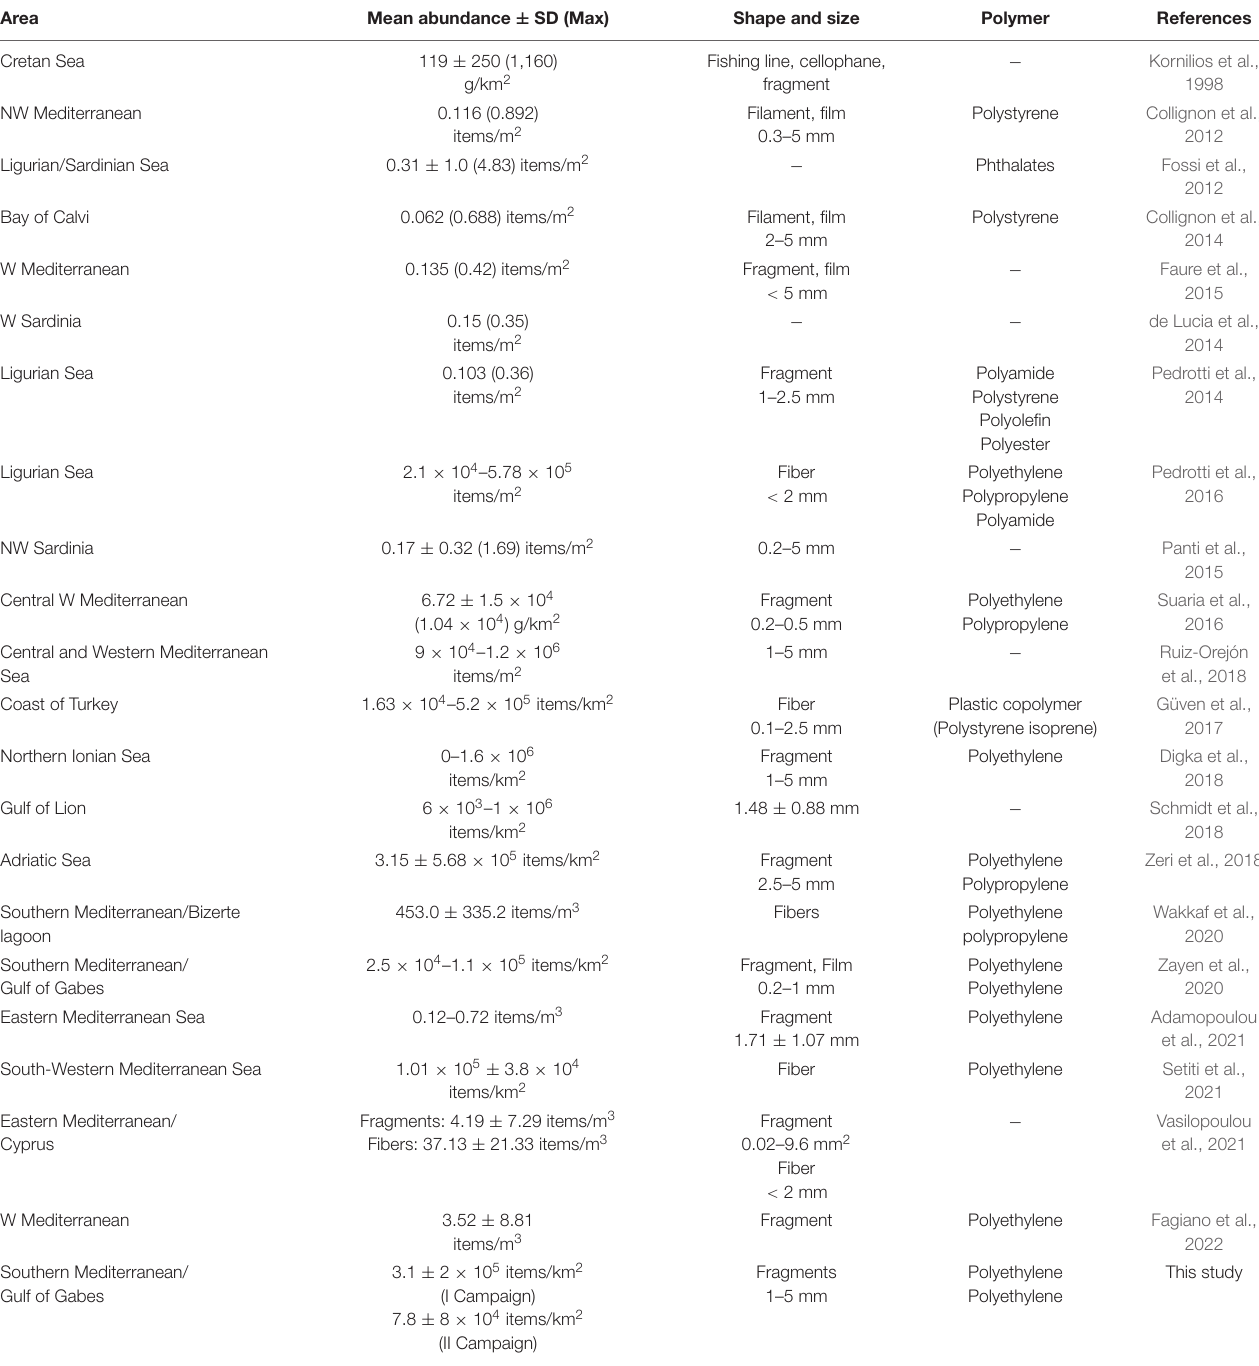
TABLE 5 | MPs abundance values found in surface waters from Mediterranean